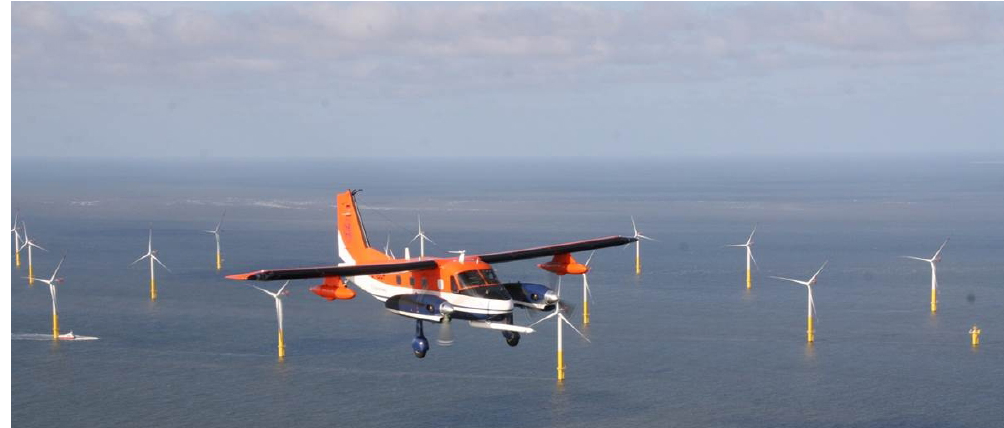
Figure 1. The Dornier 128 D-IBUF in front of a wind park on 10 August 2017. Photo: Mark Bitter, TU